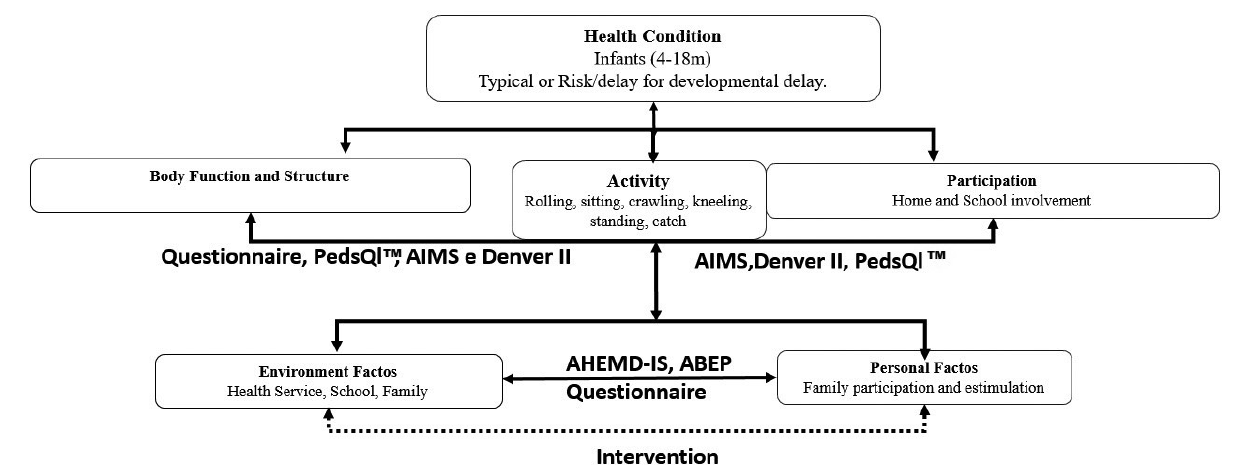
Figure 3.Organization of the evaluation scales by the ICF